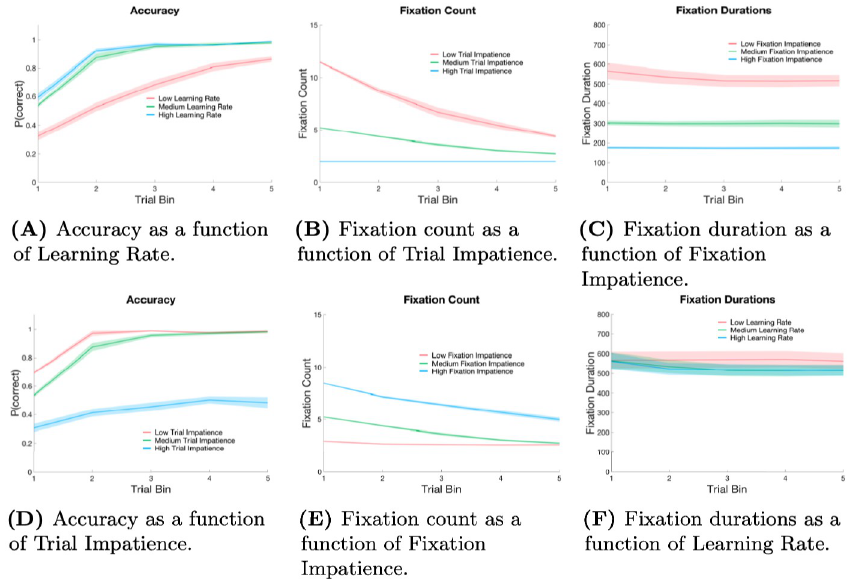
Fig 4. Simulation 1: Experiment and model stimuli examples. A) An example stimulus from the response phase (top) and feedback phase (bottom) from [25]. Each feature type subtends approximately 1.7˚ of visual angle, separated by 10.6˚. B) The features as they look to LAG-1 during the response phase (top), and feedback phase (bottom) showing the location of the feedback button. Features are represented as simple color patches (top right). The feedback button provides the correct answer when foveated by the model. Also depicted by a solid black outline top the top right feature is 1 standard deviation of LAG-1’s fovea, given a fixation to the top right hand feature, where the dashed line reflects 2 standard deviations from highest acuity. Stimuli are counterbalanced between subjects, such that features appear at different locations and have differing relevance.